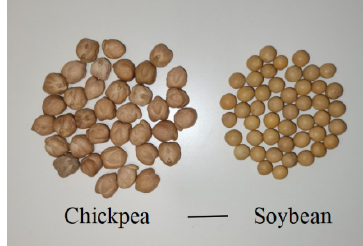
Figure 7. Chickpea and Soybean. Scale bar = 1